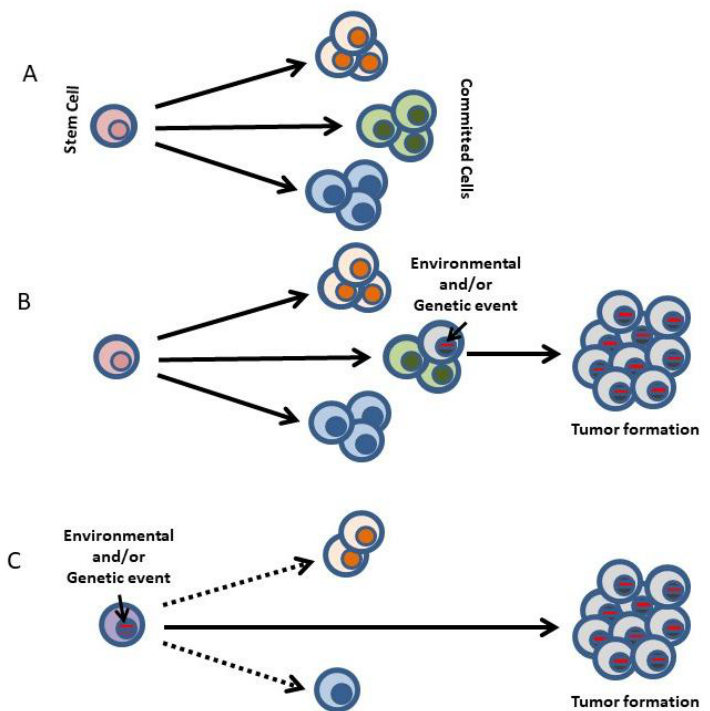
Figure 2. Proposed model for the role of human cancer gene defects in the making of a leukemia. ( A ) In the development of every normal tissue, a small pool of multipotent stem cells maintains multiple cell lineages. ( B ) Traditionally, human cancer genetic defects have been thought to act on cells already committed to a differentiation program. Hence, the cancer phenotype closely resembles that of the initial differentiated target cell. ( C ) Normal uncommitted stem and progenitor cells are the targets for transformation in some human cancers, and the human cancer-gene defects into these cells are the instigators of lineage choice decisions, which are therefore dictated by the oncogene and not by the cell-of-origin phenotype. Consistent with this is the finding that forced expression of these genes in stem cells can select or impose a specific cancer-lineage outcome. This explains why specific gene defects are usually found only in one type of cancer (see text for details). Dotted lines depict cell lineage choices that were not imposed by the oncogene.